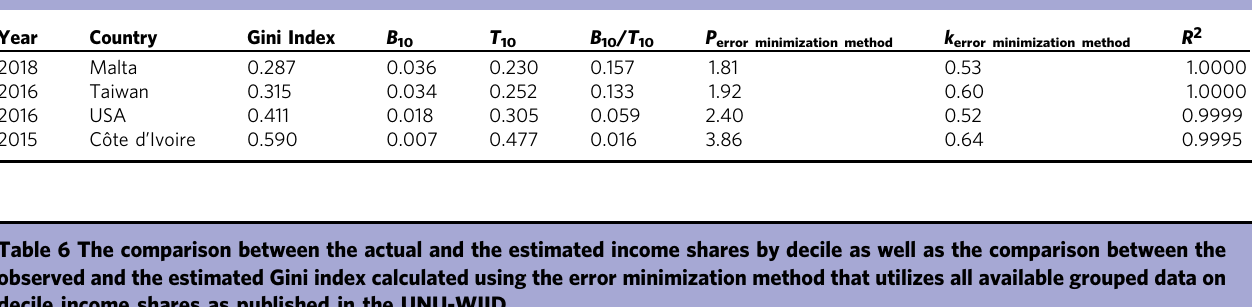
Table 5 The estimated parameters P and k for the Lorenz curves of four countries calculated using the error minimization method that utilizes all available grouped data on decile income shares as published in the UNU-WIID.